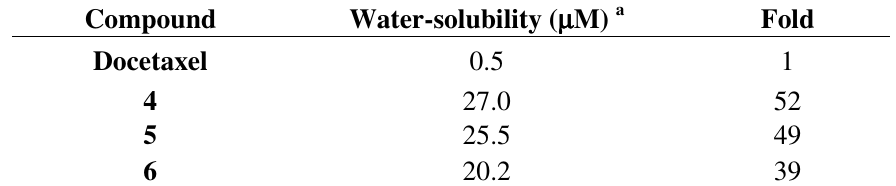
Table 1. Water-solubility of 7-propionyldocetaxel 3''- O - β - D -glycosides 4 – 6 .